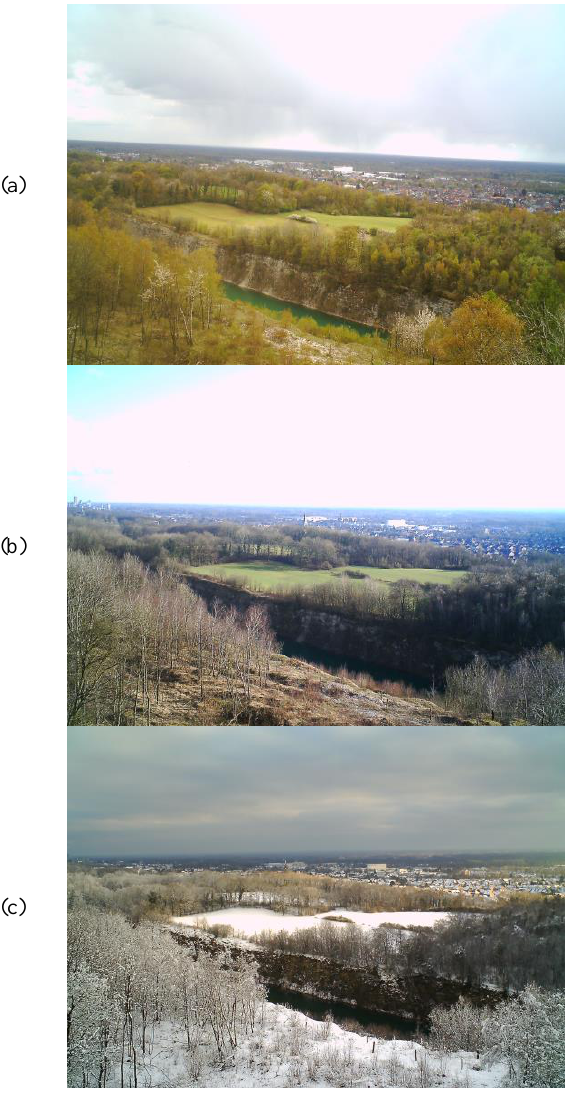
Figure 4. Resulting photographs at three various points of time,